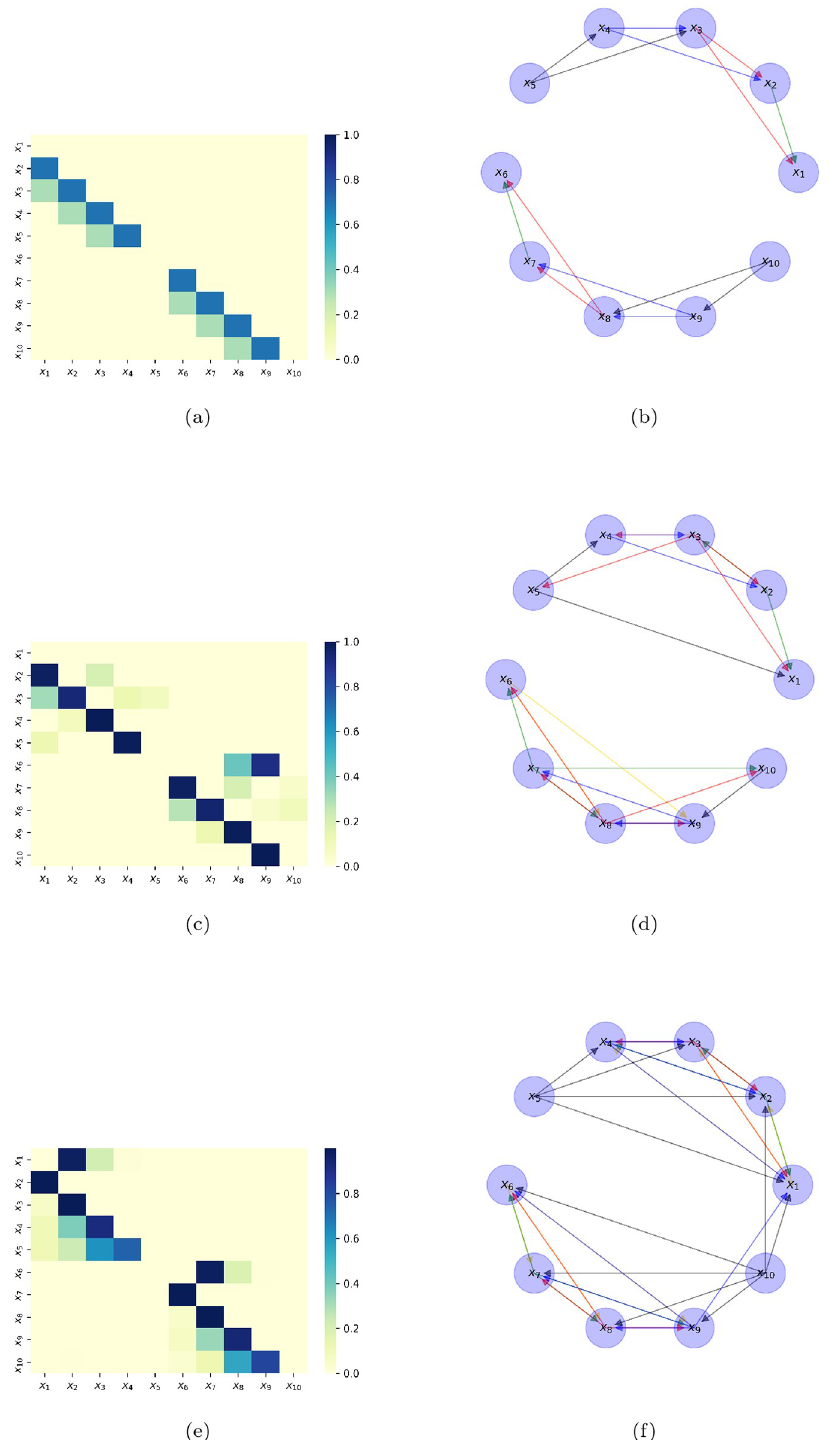
Fig 2. System 2. (a) Heatmap of the interaction matrix A. (b) Directed graph of the interaction matrix A. (c) Heatmap of the STE detected interactions. (d) Directed graph of the STE detected interactions. (e) Heatmap of the Granger causality detected interactions. (f) Directed graph of the Granger causality detected interactions.